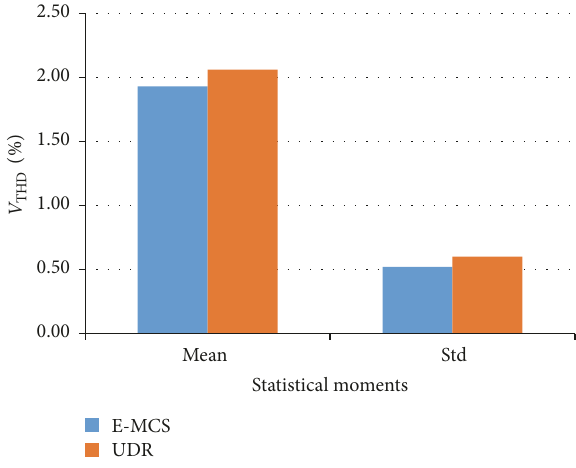
Figure 12: Predicted VgaTHD using E-MCS and rUDR 5 pts for Uniform Power Variation.